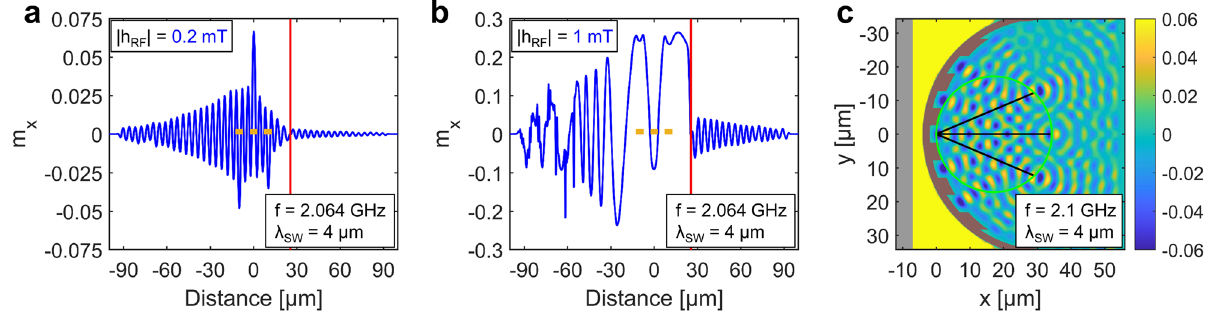
Figure 4. Micromagnetic simulations of nonlinear indirect excitation of spin waves. Yellow rectangles indicate the CPW position and width. The red stripe represents the FIB irradiated region, modelled by zero M s . ( a ) is a 1D example of linear excitation, while ( b is a strongly nonlinear case. ( c ) represents a 2D simulation of the experimental scenario in Fig. 2b.